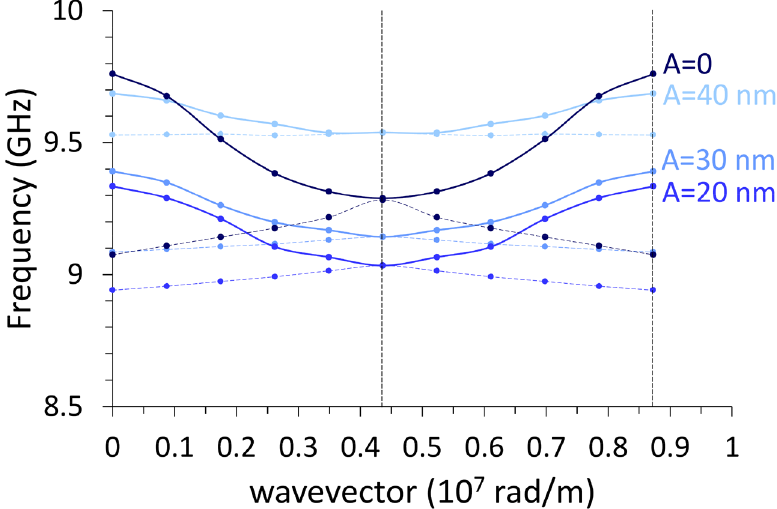
Figure 8. BA mode dispersion curves for the 1st (thick solid lines with full symbols) and mirrored 2nd zone (thin dashed lines) in configuration M (cid:31) x . The same blue shades from darker to lighter of Fig. 5, correspond to the film (A = 0), and in order, the 4, 6, and 8-stripe system, with indication of the corresponding undulation amplitude A. The 12-stripe (A = 60 nm) system is missing since no bulk solutions are allowed due to the strong dipolar fields arising after magnetizing the stripes along the